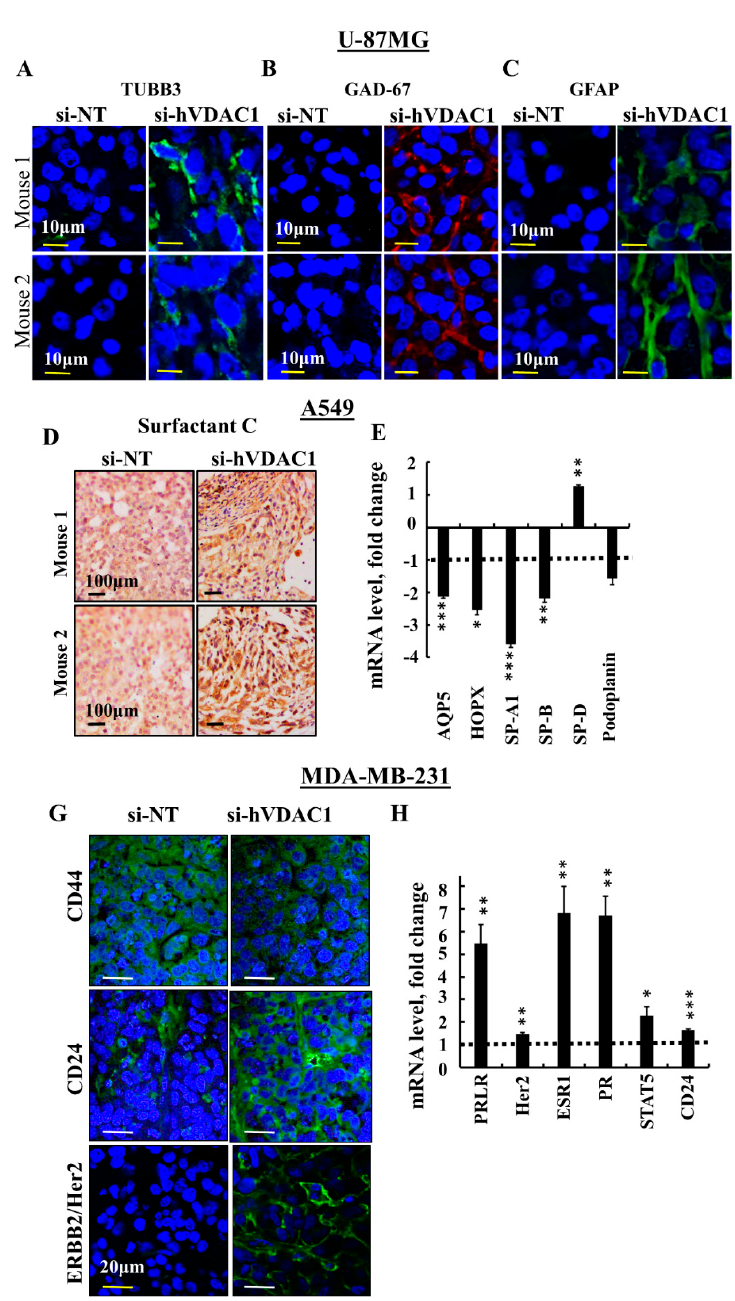
Figure 5. si-hVDAC1 treatment of U-87MG-, A549- and MDA-MB-231-derived tumours induces expression of proteins associated with differentiation. U-87MG cells-derived hVDAC1-TTs or si-NT-TTs were stained with anti-TUBB3 ( A ) anti-GAD-67 ( B ) or anti-GFAP antibodies ( C ) with representative images from 2 mice each shown. A549 cell-derived hVDAC1-TTs or si-NT-TTs were stained for surfactant C ( D ) or subjected to q-RT-PCR to analyse expression levels of the indicated genes ( E ). MDA-MB-231 cell-derived hVDAC1-TTs or si-NT-TTs were stained with anti-CD44, -CD24 or -ERBB2/Her2 antibodies ( G ). mRNA levels of the indicated genes were analysed in si-hVDAC1-TTs and are presented relative to those in si-NT-TTs ( H ). Results are means ± SEM ( n = 3); p : * ≤ 0.05; ** ≤ 0.01; *** ≤ 0.001. Dashed line indicates the control